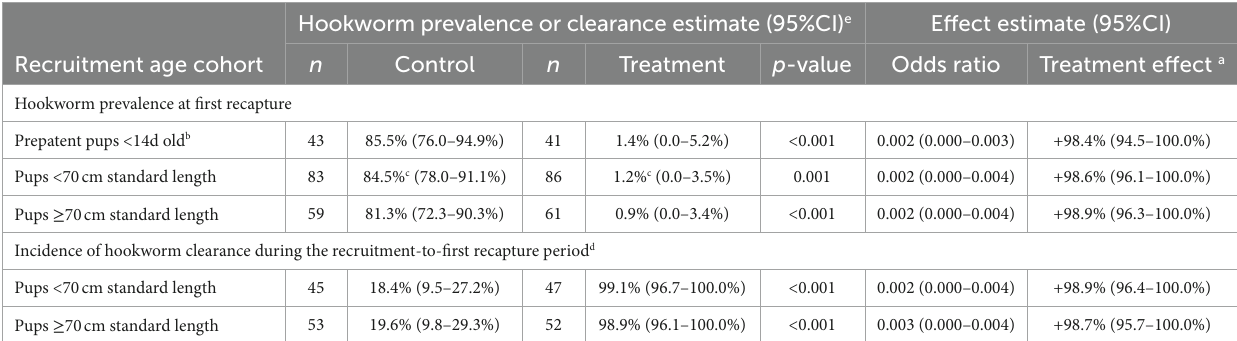
b As these pups were prepatent at recruitment, the prevalence at first capture corresponds to the incidence of infection until first recapture. c The final model includes a significant interaction between treatment and pup age. The reported estimates correspond to the prevalence of an average aged pup in either treatment group. d Treatment effectiveness for the incidence of clearance (recruitment-to-first recapture period) calculation in pups with patent infection at recruitment used the predicted proportion of patent infection at recapture (the complement of clearance from recruitment-to-first recapture). e Hookworm prevalence and incidence estimates were calculated using Firth’s variant of the multifactorial logistic regression. The base additive model included treatment group, season, and pup age at first recapture. Ancillary factors assessed for significance were sex; bodyweight, standard length, and body mass index at first recapture; first recapture fieldtrip; and the recruitment- to-first recapture period